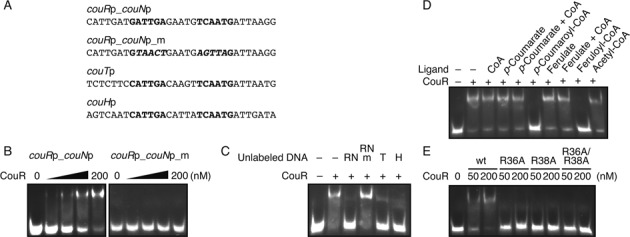
EMSA analyses of CouR. (A) DNA sequences used for the EMSA analyses. The predicted CouR boxes are indicated in bold characters. The italicized characters indicate the nucleotide substituted. (B) EMSA analysis of the CouR wt to the couR and couN promoter region. A varying concentration of the CouR wt (0, 25, 50, 100 or 200 nM) was incubated with 1 nM DIG-labelled couRp_couNp or couRp_couNp_m probe. (C) EMSA analysis of the CouR wt to the couRp_couNp probe in the presence of the unlabelled couRp_couNp (RN), couRp_couNp_m (RNm), couTp (T) or couHp probe (H). (D) EMSA analysis of the CouR wt to the couRp_couNp probe in the presence of CoASH, p-coumarate, ferulate, p-coumaroyl–CoA, feruloyl–CoA or acetyl–CoA. (E) EMSA analysis of the CouR wt, R36A, R38A and R36A/R38A to the couR and couN promoter region. A varying concentration of CouR (50 or 200 nM) was incubated with 1 nM DIG-labelled couRp-couNp probe.